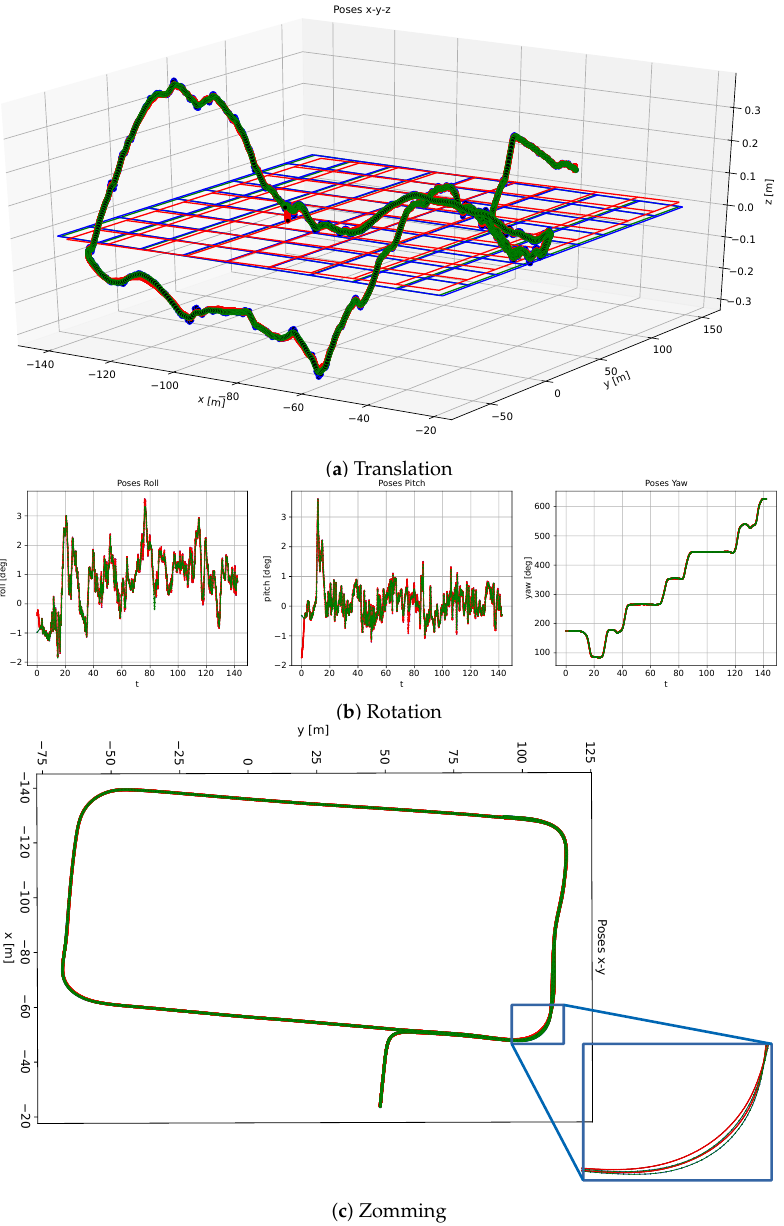
Figure 3. Plotting of the visual localization poses (highlighted with blue color), motion fusion results using pose-graph-based approach and IMU pre-integration (highlighted with red color), and using our uniform B-spline-based approach (highlighted with green color) for comparison. ( a ) The 3D position plotting. ( b ) The 3D orientation plotting with roll, pitch, and yaw angles. ( c ) The 2D position plotting with detailed zooming of one critical part. Here, we can see that the green curve is closer to the blue curve than the red curve, which means that our approach can estimate the motion fusion results more